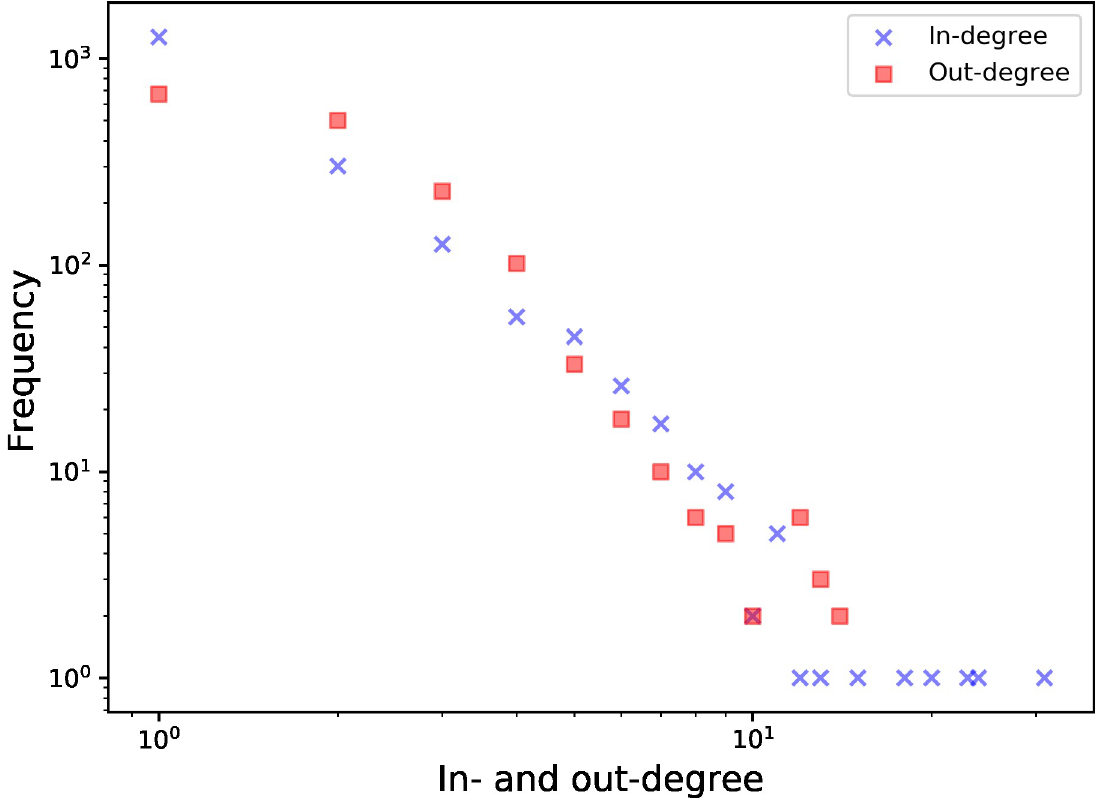
Fig 6. Degree distribution of in-degree (blue crosses) and out-degree (red squares) on a log-log scale for the monthly network of October 2017.